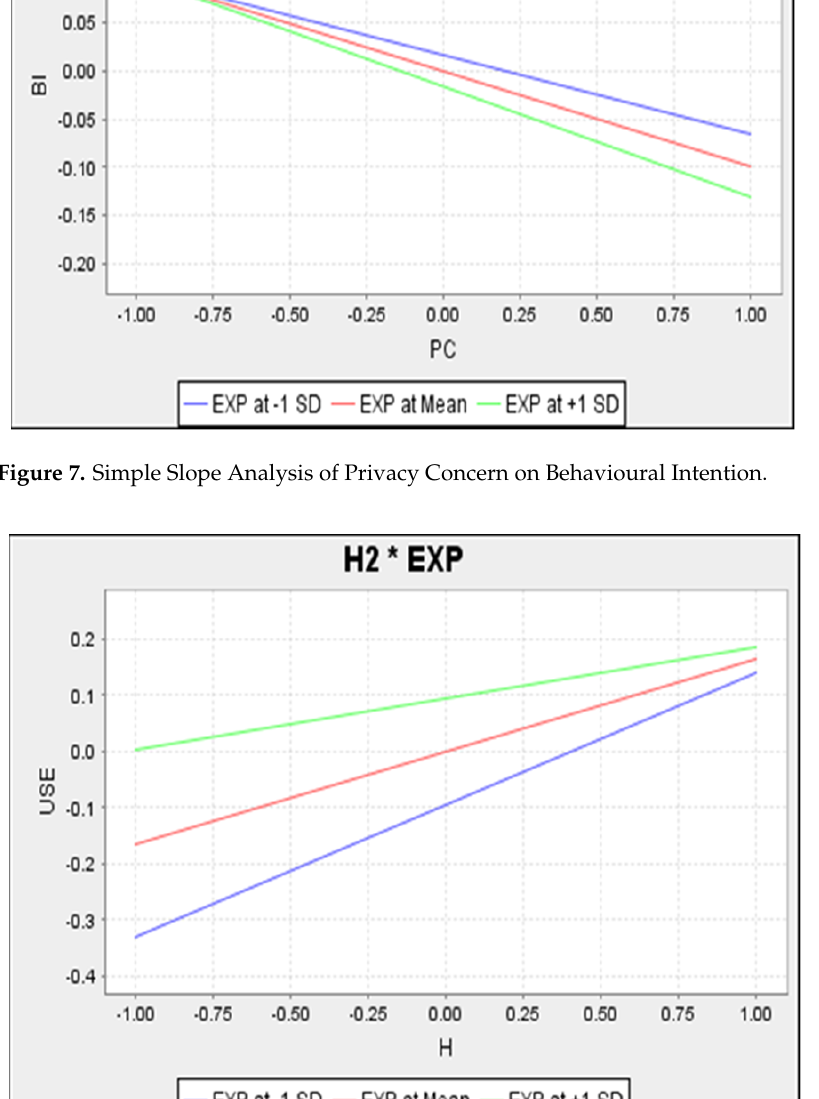
Table 6. Moderating effect of personal innovativeness. Hypothesis